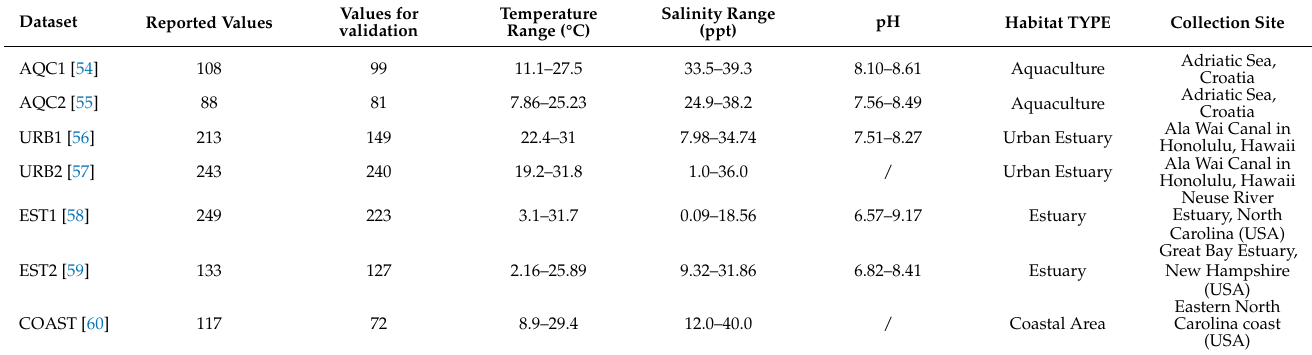
Table 5. The seven datasets used for model validation. AQC1 and AQC2 were previously unpub- lished; the other datasets are publicly available and can be accessed through the provided reference. Information for each dataset contains reported values (i.e., the number of entries in a dataset), values used for validation (i.e., the number of observations after the missing values were removed from the dataset), temperature, salinity, and pH range. Seven datasets used for model validation were classified into four habitat types based on the characteristics of the collection sites. Methods used for determining Vibrio spp. abundance are listed in Appendix